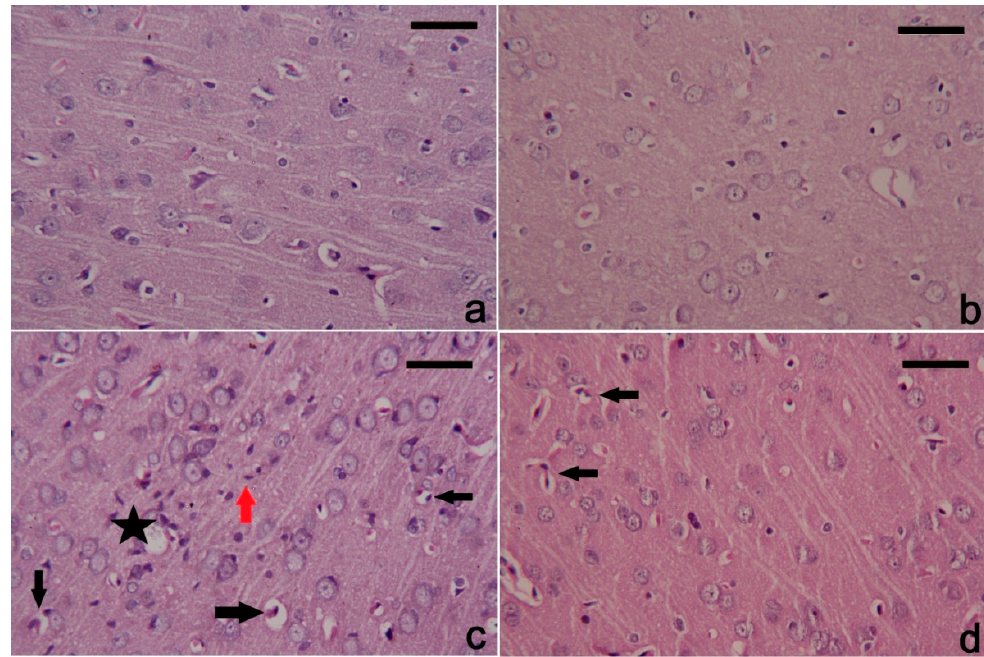
Figure 7. Histopathological changes in cortical tissue following treatment with coenzyme Q10 and lead acetate. ( a ) and ( b ) showing normal cortical structure of control and coenzyme Q10 treated rats; ( c ) section from the lead acetate treated rat showing intracellular and extracellular vacuoles and oedema around the cell (black star), many inflammatory cell infiltration (red arrow), and degenerated neurons with deeply stained nuclei indicating apoptosis (black arrow). ( d ) post-treatment with coenzyme Q10 markedly attenuated all cortical damage caused by lead acetate. However, a few degenerative neurons in the cortical tissue are still found. Hematoxylin and eosin (H&E). Scale bar 100 nm.